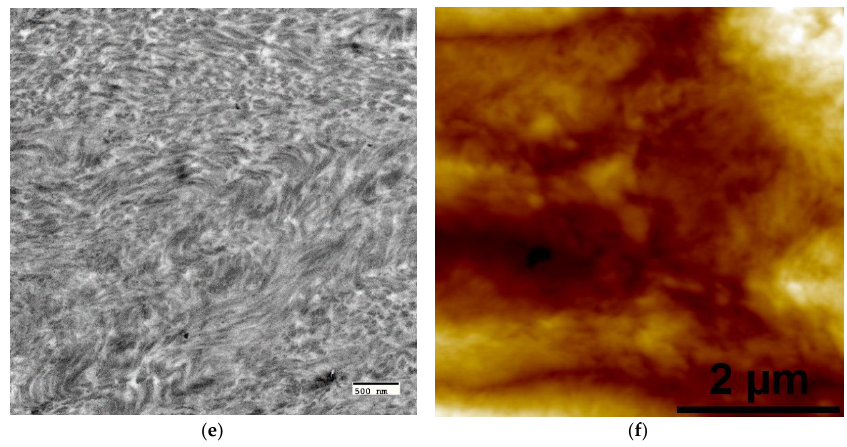
Figure 1. Representative cross-sectional transmission electron microscopy (TEM) ( a , c , e ) and complementary atomic force microscopy (AFM) height images ( b , d , f ) showing organized and disorganized regions in crosslinked liquid crystalline collagen (LCC) film X51. ( a , b ) Low mag images demonstrate cholesteric collagen microstructural organization due to the changing orientation of parallel-fibril arrays through successive layers. ( a ) Despite uranyl acetate staining, the contrast of non-mineralized LCC was poor at low magnifications due to artifacts (wrinkles, dark lines) created during the ultra-thin sectioning process; the black box denotes the ROI for the image shown in ( c ). ( b ) In AFM, periodic peaks and valleys (an artifact created from interaction of the knife with the twisted plywood structures during semi-thin sectioning) can be visualized as lighter regions corresponding to elevated peaks and darker areas as valleys; the white box denotes the ROI for the image shown in ( d ). ( c ) At higher magnification in TEM, fibrils in lamellae with axes orientated parallel to the image plane appear filamentous (layers denoted by double-sided arrows); in the other layers fibrils oriented perpendicular or oblique to the image plane appear as small ovals. ( d ) At higher magnification in AFM, height images show better contrast from periodic peaks and valleys with sub-micron roughness, likely the result of an oblique orientation of collagen fibrils in successive lamellae [40]. ( e , f ) Between large (~10 – 40 μ m) cholesteric domains, small regions (~1 – 3 μ m) of disorganized collagen fibrils could be found. Scale bars: ( a , c , e ) 500 nm; ( b ) 10 microns; ( d , f ) 2 microns.